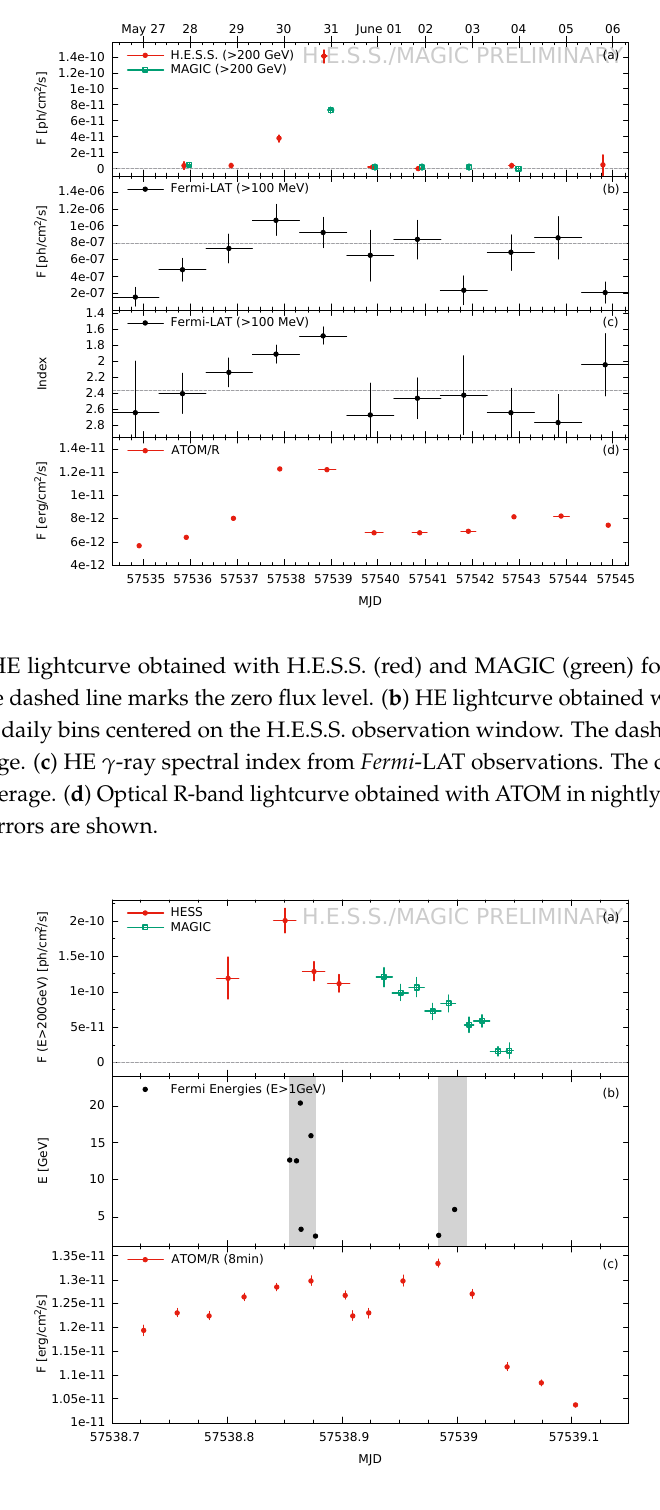
Figure 6. ( a ) VHE lightcurve obtained with H.E.S.S. (red) and MAGIC (green) for E > 200GeV in 28min and 20min bins, respectively, for the maximum night, May 30th, 2016 (MJD 57538). ( b ) Individual photons detected with Fermi -LAT with the gray bands indicating the visibility window of PKS 1510-089 for Fermi . ( c ) Optical R-band lightcurve obtained with ATOM in 8 min bins. In all panels only statistical errors are